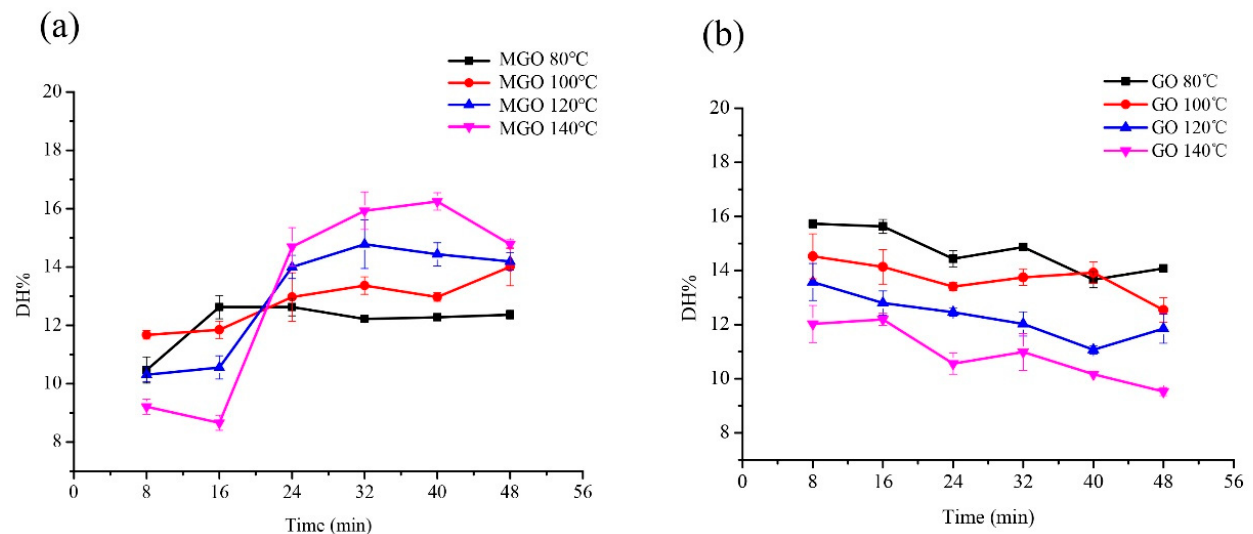
Figure 2. Effect of temperature and duration on the digestibility of glycated glutenin derived from MGO and GO. ( a ) Glutenin (1 mg/mL) with MGO (40% aqueous solution) was incubated for 8, 16, 24, 32, 40, and 48 min at different temperatures (80, 100, 120, and 140 ◦ C) with the mass ratio of glutenin to MGO of 1:5. ( b ) Glutenin (1 mg/mL) with GO was incubated for 8, 16, 24, 32, 40, and 48 min at different temperatures (80, 100, 120, and 140 ◦ C) with the mass ratio of glutenin to GO of 1:5. Data show the means ± SD of triplicate independent experiments. Bars represent the standard error of the mean.